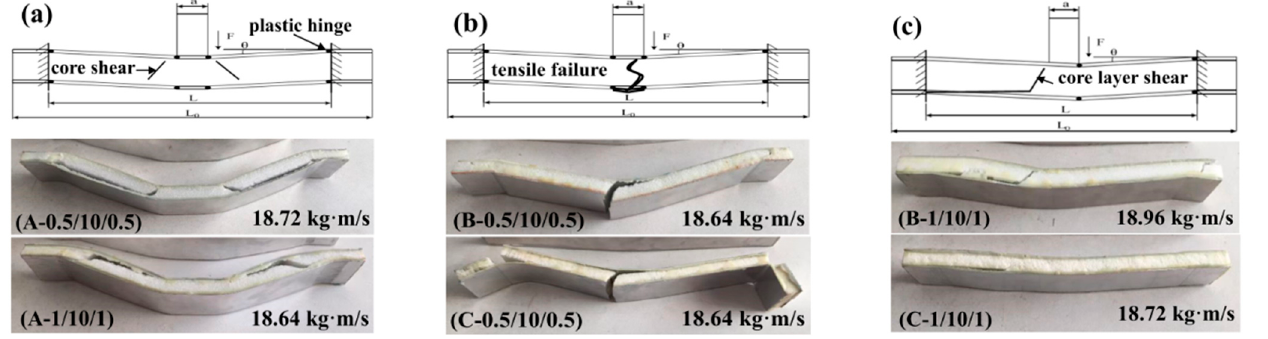
Figure 14. Failure modes and deformation mechanisms of the thin-core sandwich beams with dif- ferent thicknesses of face sheets and different densities. ( a ) 52 kg/m 3 ; ( b ) 110 kg/m 3 ; ( c ) 200 kg/m 3 .